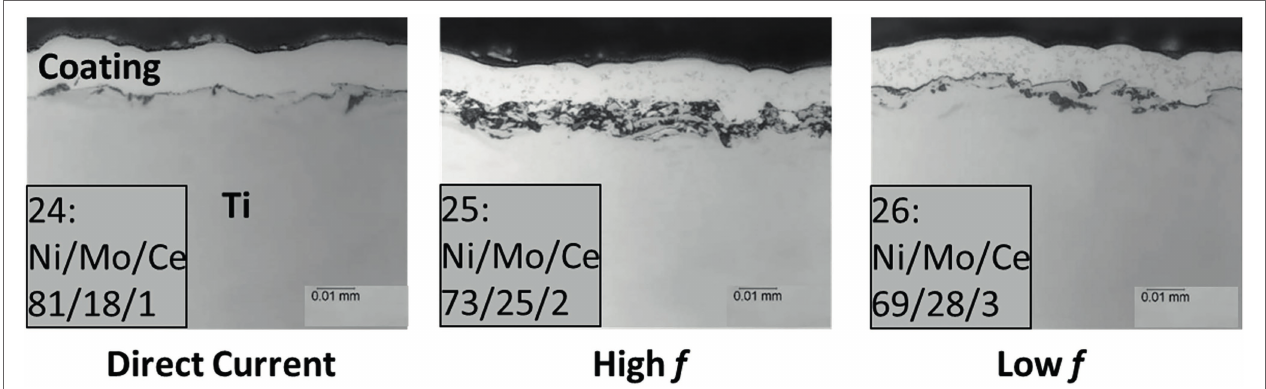
FIGURE 2 | Cross-sectional images of coatings with 100 nm CeO 2 NP inclusions directly applied to Ti surfaces under various electrocodeposition conditions (DC, high frequency and low frequency). Sample numbers and metal percentages ( w / w ) are shown. The top layer above a coating is